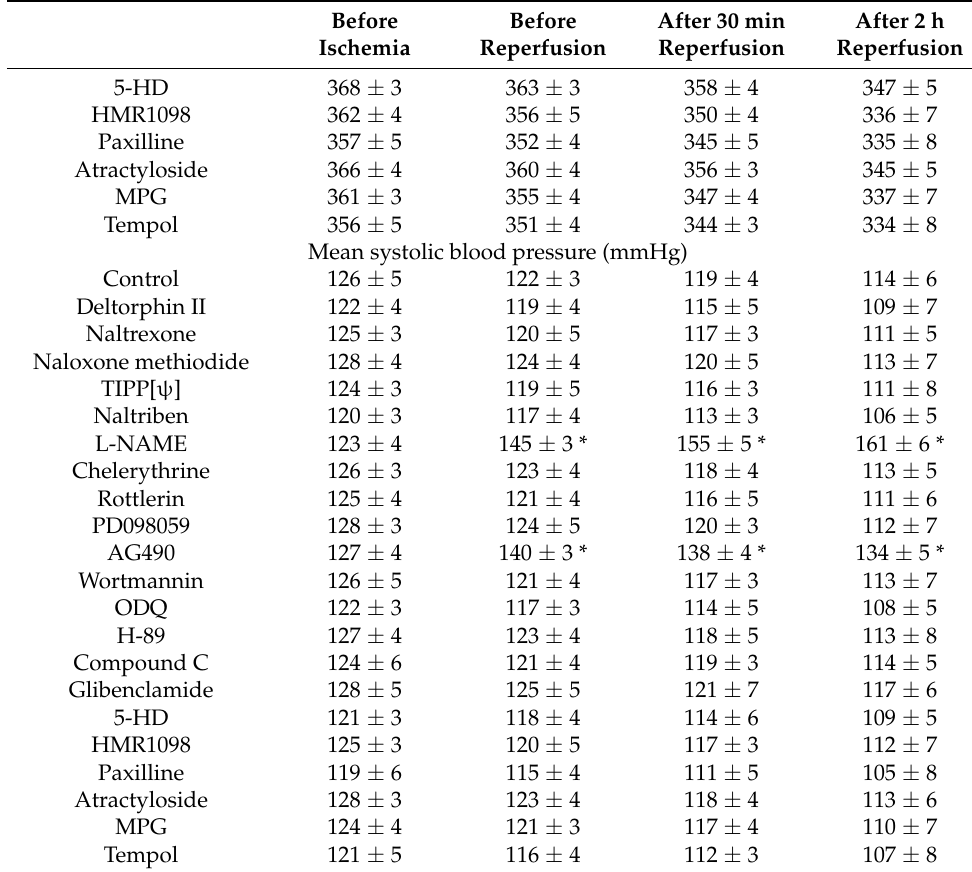
None of the used OR antagonists had an effect on the infarct size/area at risk ratio (Figure 1).